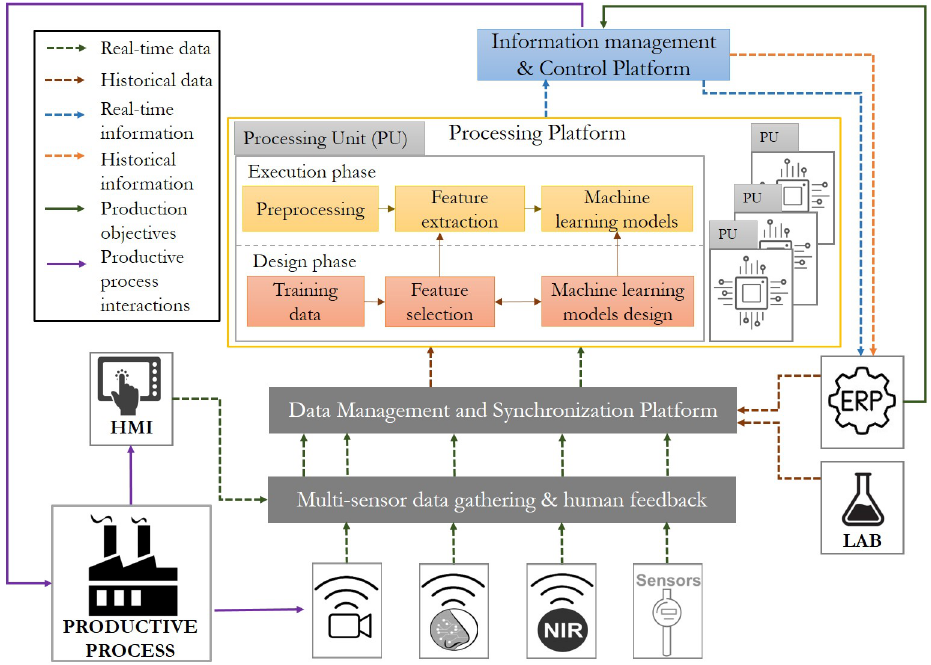
Figure 4. Reference architecture for the implementation of ZDM in VOO